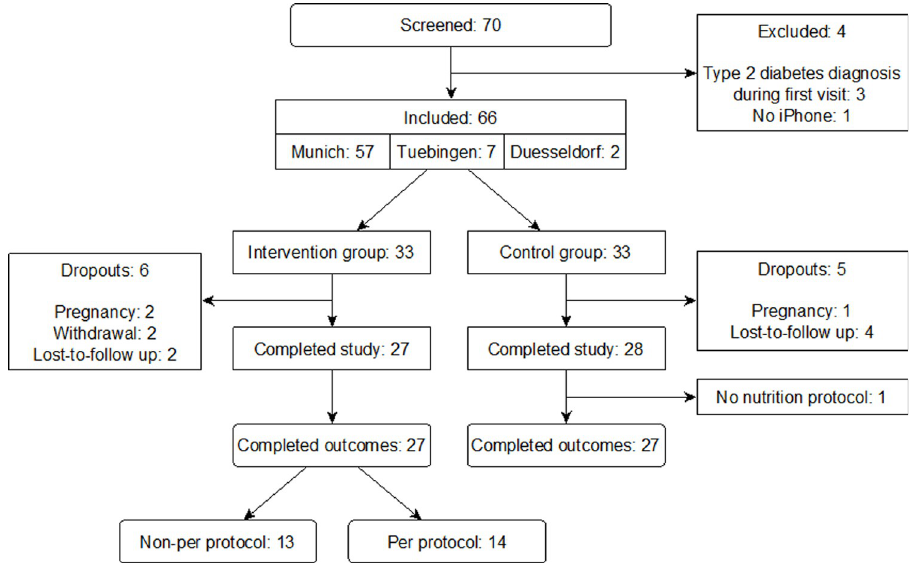
Fig 1. Screenshots of the TRIANGLE app core features. From left to right: challenge system with activity screen based on active challenges, coaching chat with in-app questionnaire, and library with exemplary article.